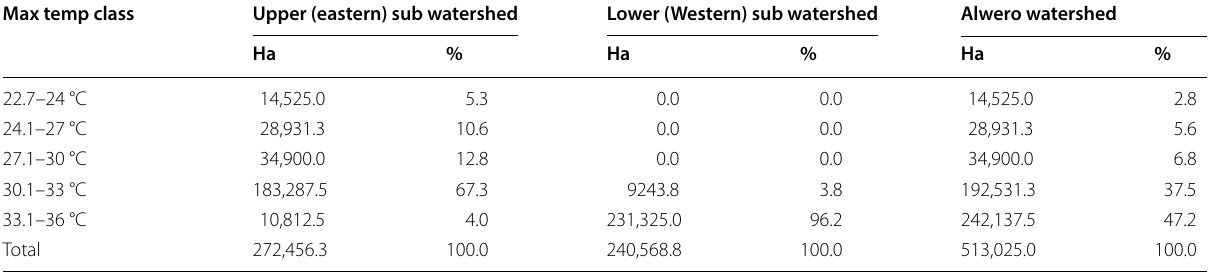
Table 5 Maximum temperature distribution in Alwero watershed Max temp class Upper (eastern) sub